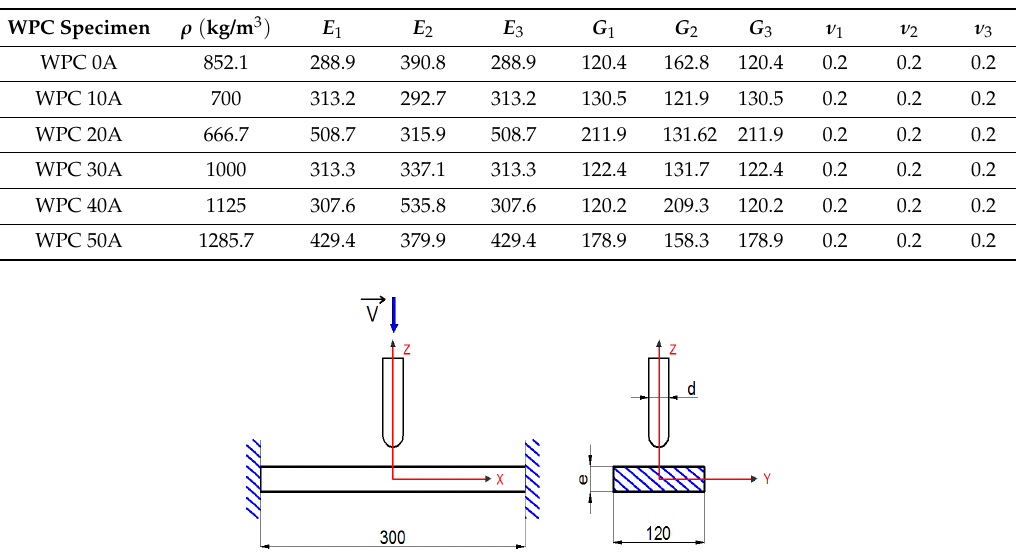
Figure 1. The modeled drop weight tests in the wood plastic composite (WPC) plate.